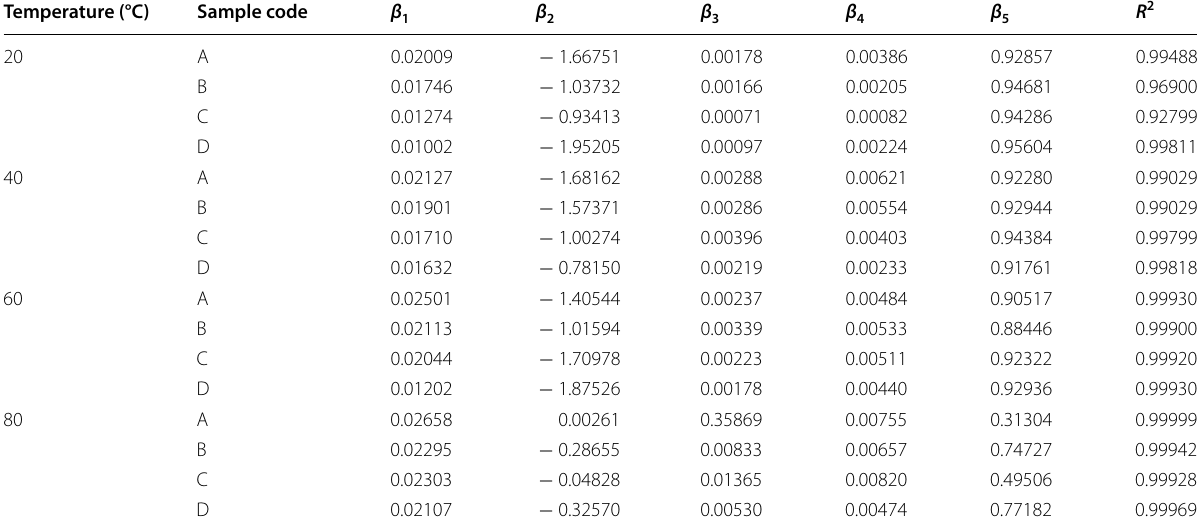
Table 3 Fitting parameters of Five-parameter model for the specimens with various distributions of earlywood vessel belt Temperature (°C) Sample